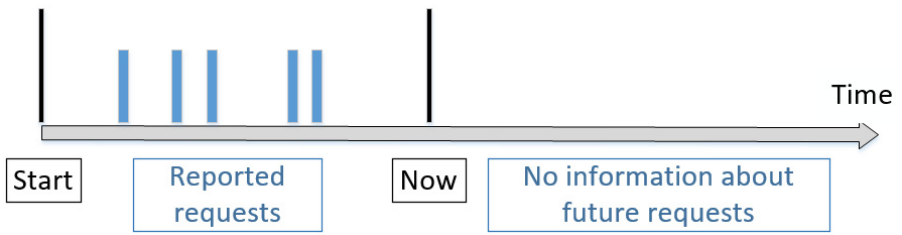
Figure 3. Overview of the temporal aspect of relief aircraft dispatch.